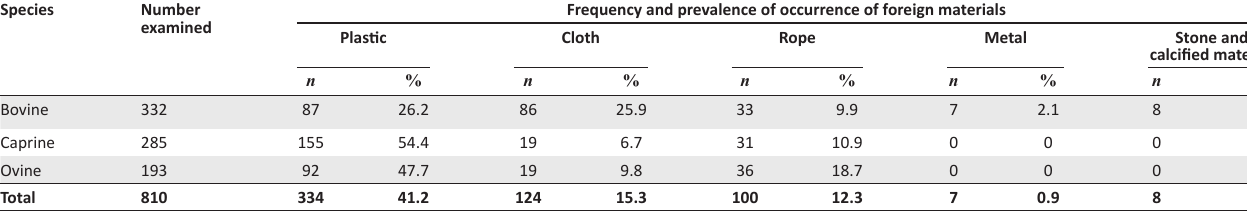
TABLE 2: Types and prevalence of foreign bodies in the rumen and reticulum of ruminants. Species Number examined